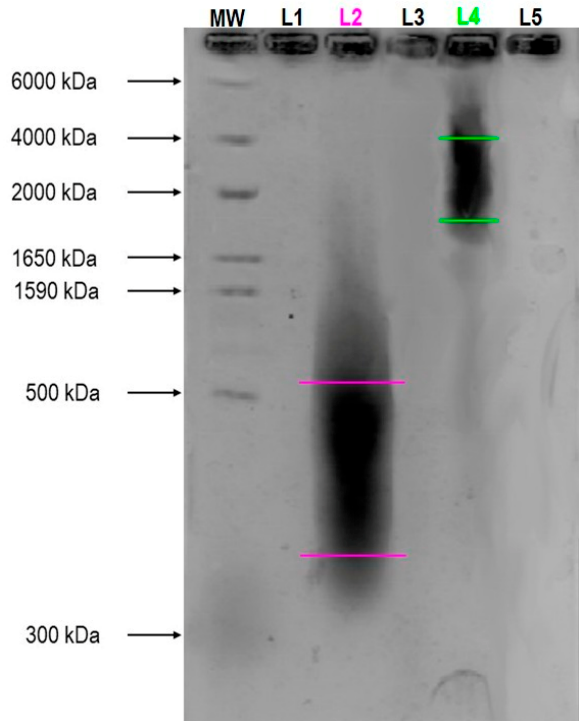
Figure 2 . In the figure an example of HA molecular weight determination on 1% Agarose gel. The sample loads are described as follows by the abbreviations: M W = standard molecular weight Mega + HiLadder specific for HA detection; L1 = lane empty loaded with 10 µL TAE buffer; L2 = lane loaded with 100 µg/10 µL Sodium Hyaluronate; L3 = lane empty loaded with 10 µL TAE buffer; L4 = lane loaded with 100 µg/10 µL GreenIuronic ® ; L5 = lane empty loaded with 10 µL TAE buffer .